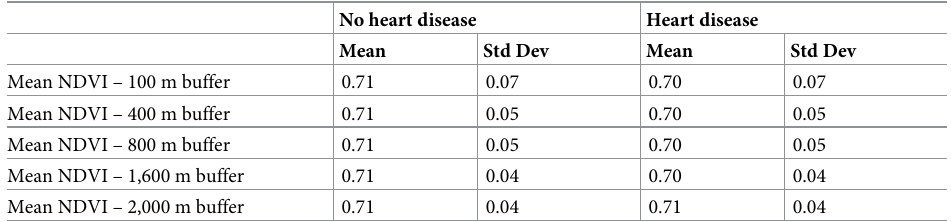
Table 2. Characteristics of NDVI (1,600 m buffer) and self-reported heart